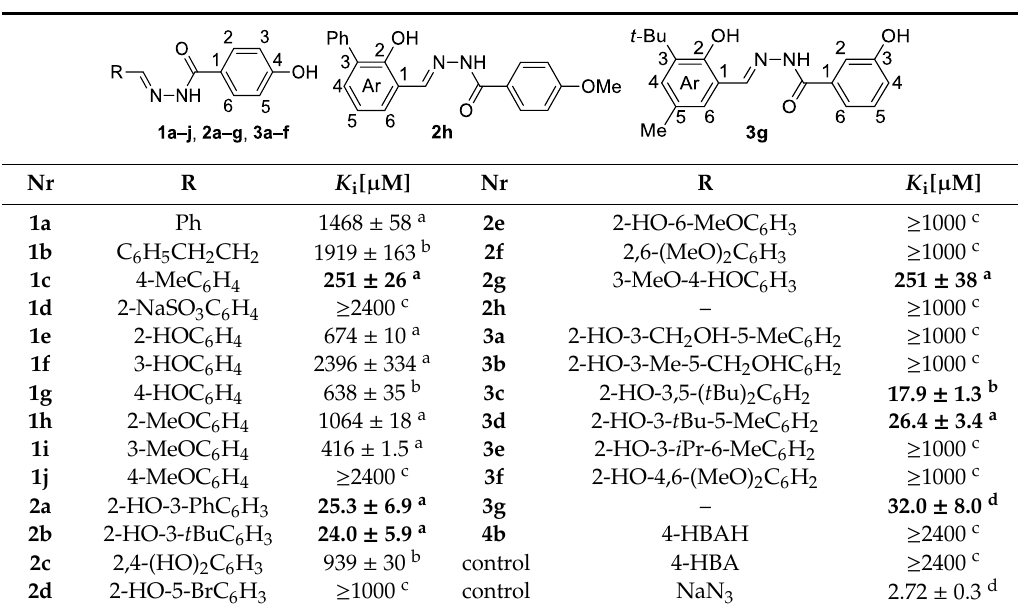
Table 2. Structures of the hydrazide-hydrazones 1a – j, 2a – h, 3a – g and their inhibition constants ( K i ) determined for laccase from Trametes versicolor , and the skeleton numbering system. Significant inhibition is marked in bold. The activity of the reference compounds, 4-hydroxybutylacrylate (4-HBA), and NaN 3 (a dioxygen reduction centre inhibitor), are given.